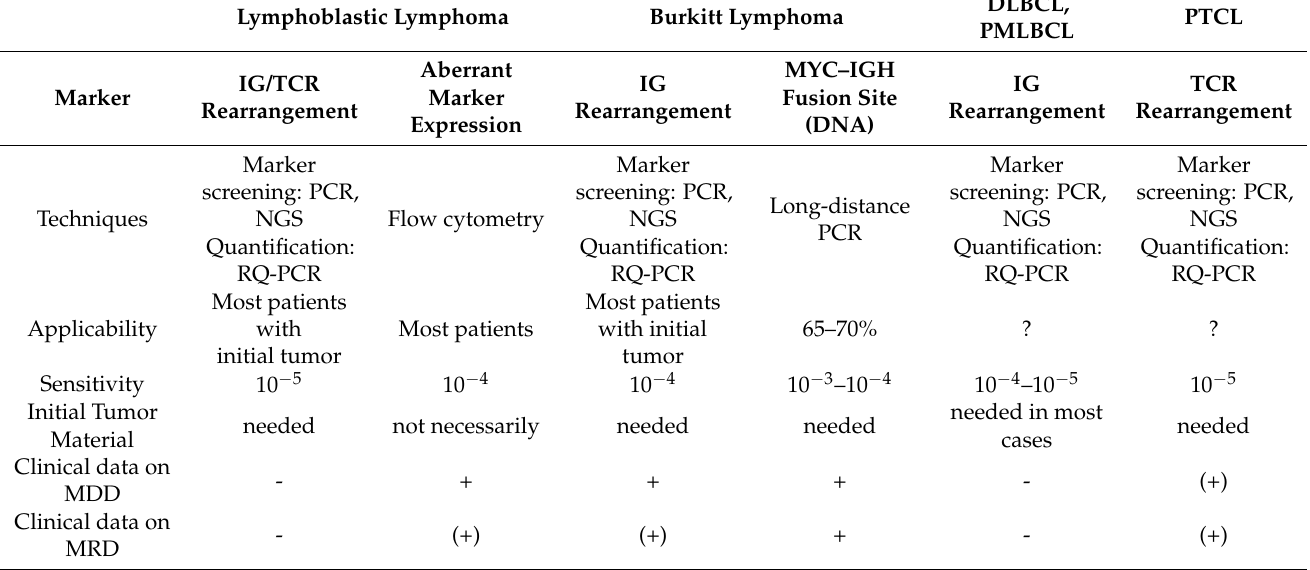
Table 1. Minimal disseminated disease (MDD) and minimal residual disease (MRD) in childhood non-Hodgkin lymphoma: possible techniques and available clinical data on lymphoblastic lymphoma (LBL), mature B-cell lymphoma (Burkitt lymphoma/leukemia, diffuse large B-cell lymphoma (DLBCL), primary mediastinal large B-cell lymphoma (PMLBCL)), and peripheral T-cell lymphoma (PTCL).